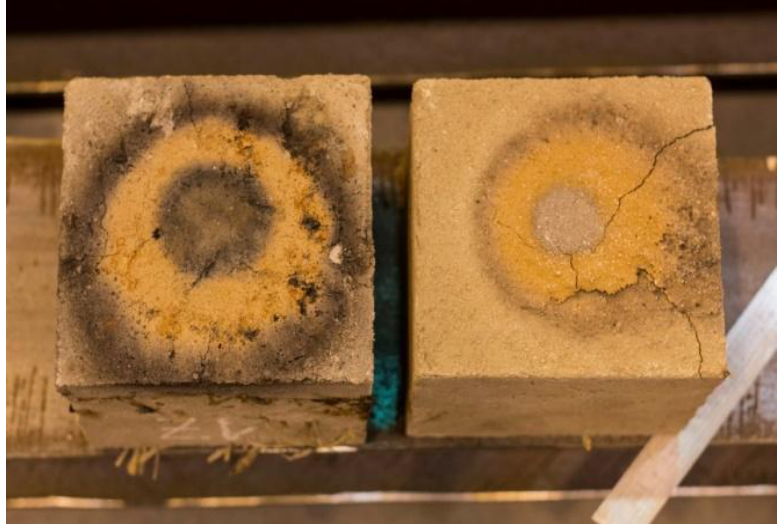
Figure 9. Surfaces of samples after completion of testing. ( Left ) Sample of light clay (P11); ( Right ) Sample of clay mortar (P16).